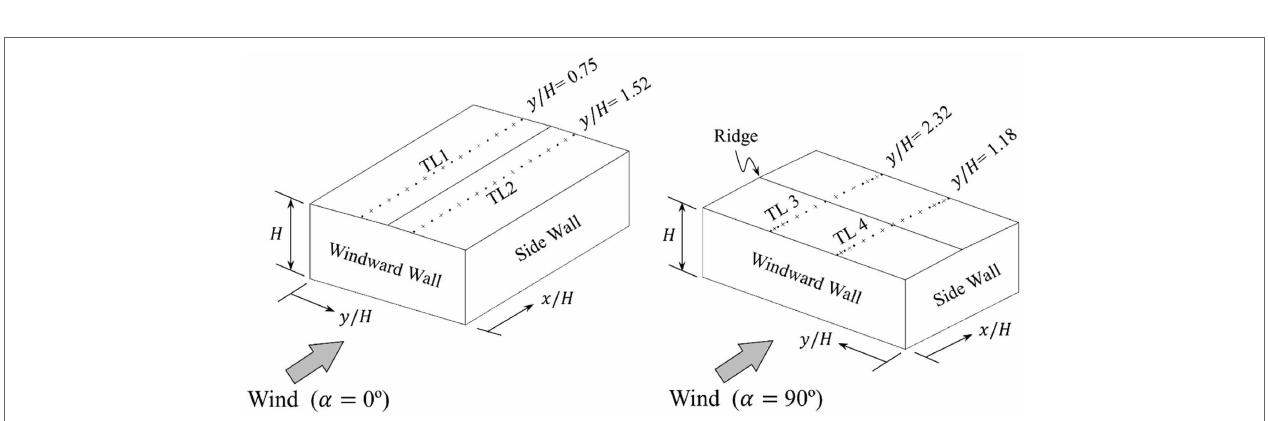
FIGURE 9 | Tap line layout parallel to the long ( α = 0 ◦ ) and short ( α = 90 ◦ ) building dimensions.